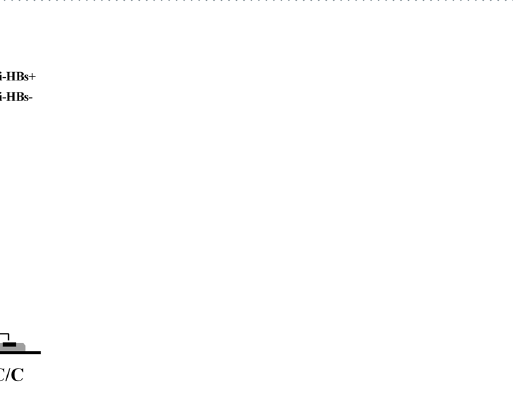
Figure 3. Phylogenetic trees were constructed for sequences from both the experimental group (red) and the control group (green) with a Bayesian method. Two complete genomes of HBV genotype D (AB090269 and AB104710) served as the outgroup sequences and three genomes (nucleotide sequences D00330 for Genotype B, AB033556 for Genotype C and FJ023667 for Genotype I) served as experimental sequences. Bootstrap values > 90% are shown.